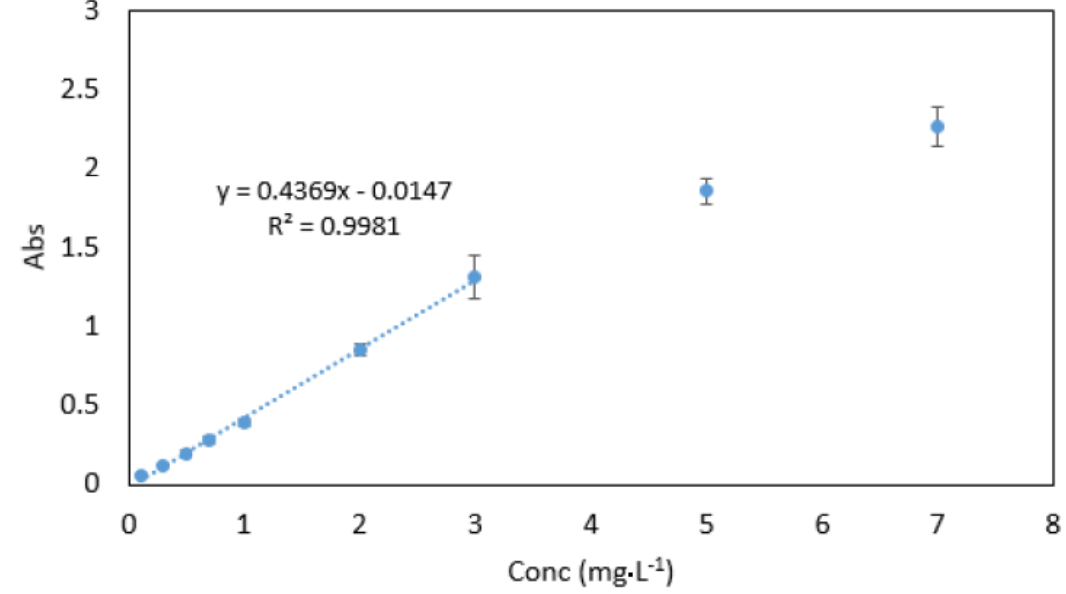
Figure 10. Calibration curve for Cr VI ranging between 0.03–7 mg · L − 1 . All measurements were carried out in triplicate ( n =